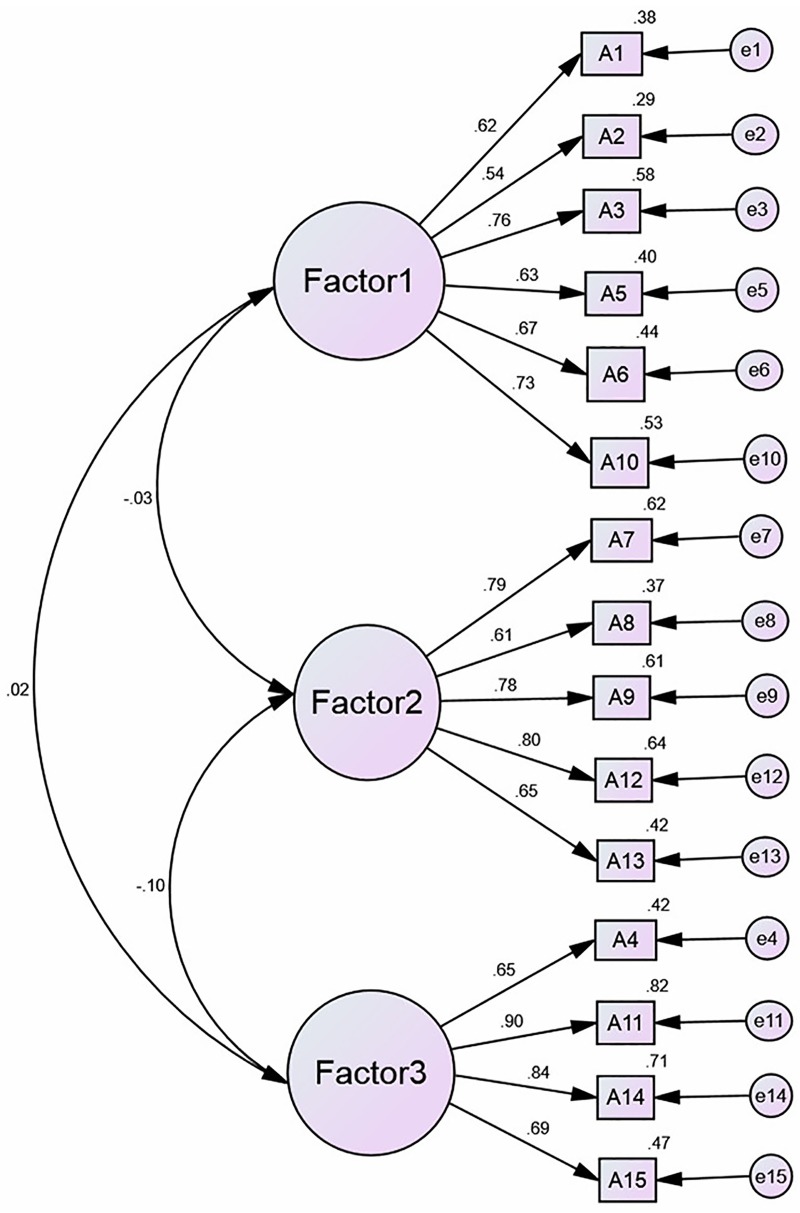
Standardized three-factor structural model of the ASAS-R-CHI (n = 576).Note. ASAS-R-CHI: the Chinese version of the Appraisal of Self-Care Agency Scale-Revised; Factor 1 (having power for self-care, 6 items), Factor 2 (developing power for self-care, 5 items) and Factor 3 (lacking power for self-care, 4 items); A1-A15: Item 1-Item 15, and each item is explained in Table 3. e1—e15: the measurement error of each observed variable to estimate latent variables.